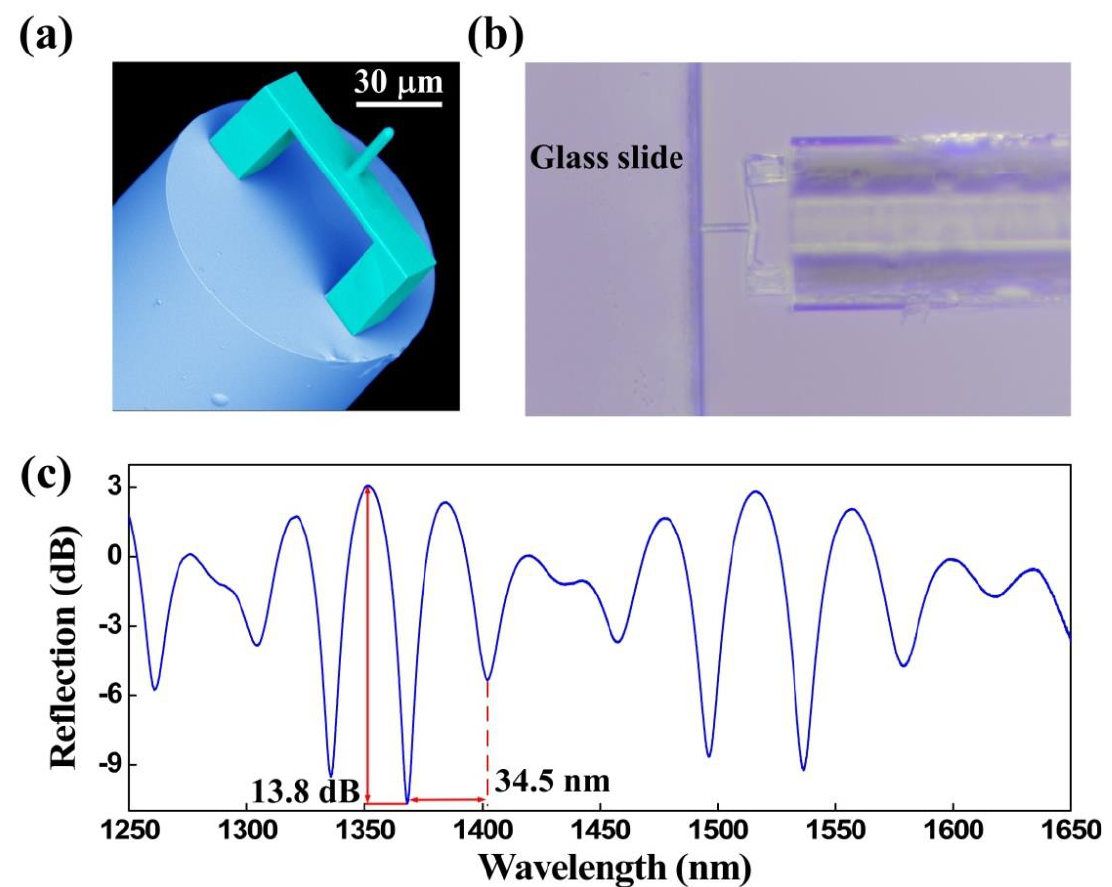
Figure 3. Characteristics of the FTMS. ( a ) SEM image of the FTMS. ( b ) Optical microscope image of the FTMS when pressed on the glass slide edge. ( c ) Reflection spectrum for the FTMS.